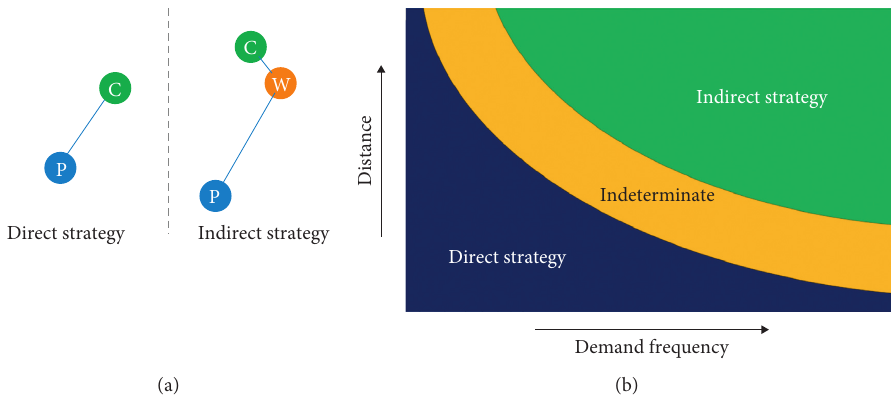
Figure 1: Shipping strategies. (a) The direct strategy (left) consists of shipping goods from the production facility (blue circle) to customers (green circle). The indirect strategy (right) delivers goods first to an external warehouse (orange circle), where goods are stored and subsequently shipped to customers (green circle). (b) Overview of the customer space and the associated optimal transportation strategies.